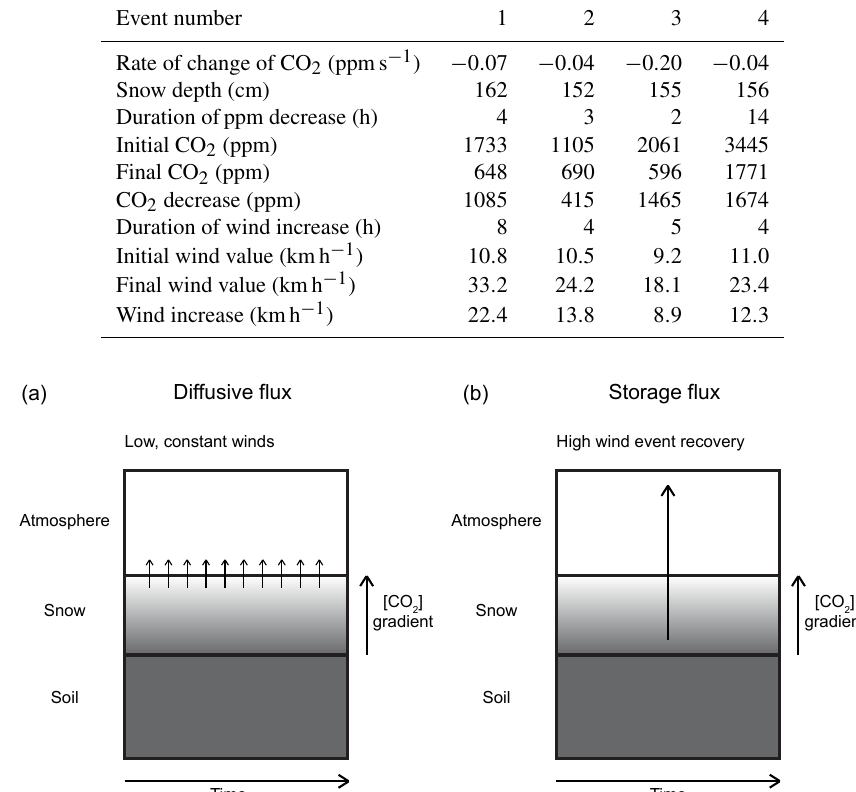
Table 4. Summary table of change in actual CO 2 concentration per second for four events in April 2015 when a decrease in CO 2 concentration corresponded to an increase in wind speed. CO 2 concentration was measured in the snowpack at 100cm from the ground. Rate of change of CO 2 concentration, snow depth, start time, end time, range of CO 2 , and range of wind speed are given in the table.